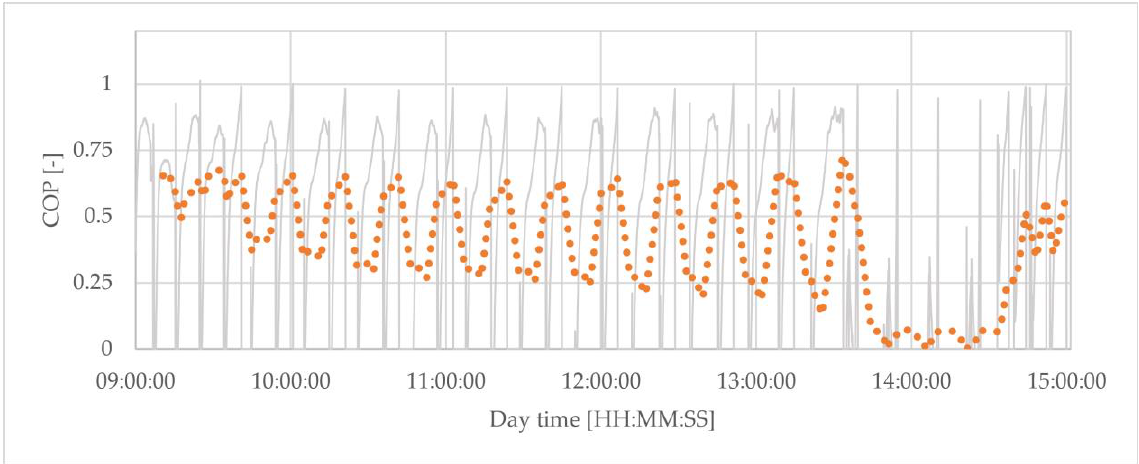
Figure 22. Fluctuation of heating power and cooling capacity values over time for 21st August. When analysing the solar irradiance curve for 21st August (Figure 22), it should be added that it was a cloudless day with a peak in solar irradiance occurring at 1 p.m. This curve is reflected in the hot water supply temperature curve, which is also parabolic